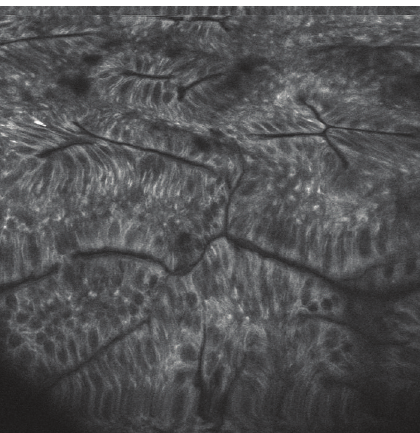
Figure 4: Confocal Endomicroscopy. Hyperplasic Polyp. Image provided by Priv.-Doz. Dr. med. Martin G¨otz, Oberarzt Gastroen- terologie I, Medizinische Klinik und Poliklinik, Universit ¨ atsklinik